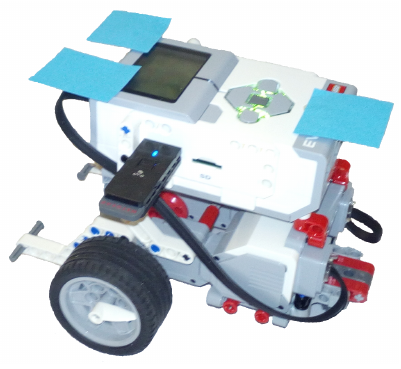
Figure 3. Experimental LEGO